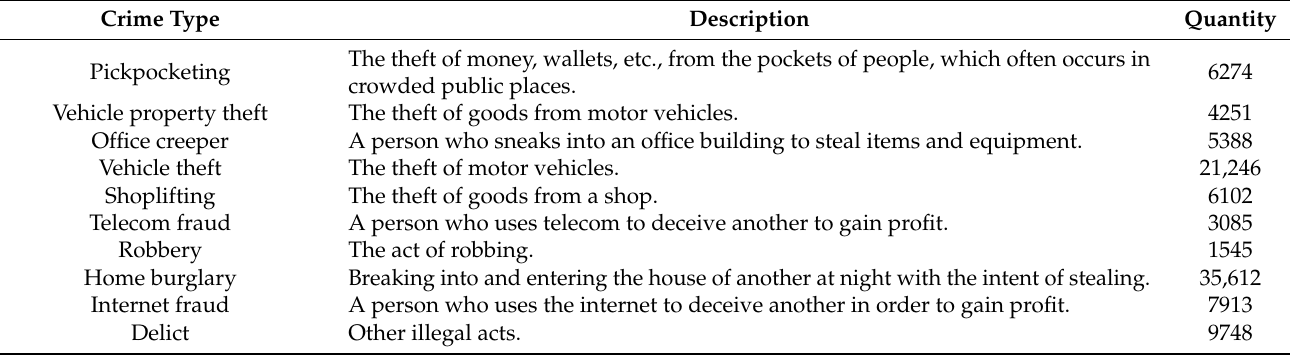
Figure 1. Kernel density map for criminal cases in the study area. Table 1. Description and quantity of crime types.